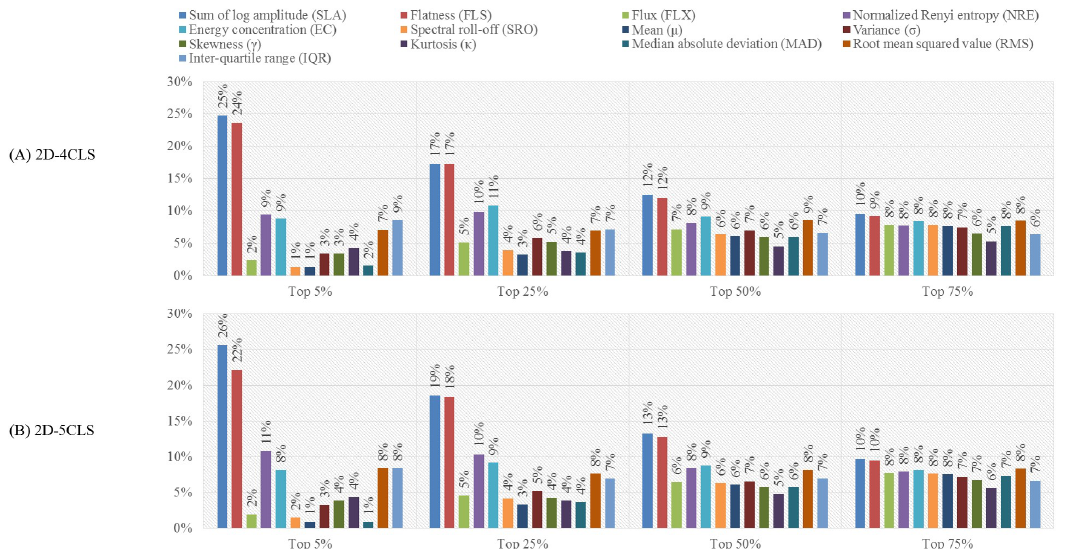
Figure 6. The ratio between the number of times each time-frequency feature is selected to the total number of selected features computed for each of the four feature selection scenarios. ( A ) presents the computed percentages for the 2D-4CLS, and ( B ) shows the computed percentages for the